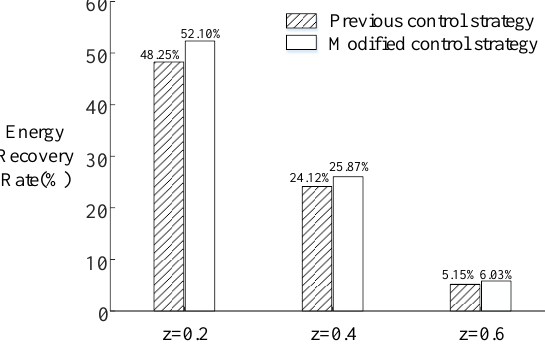
Figure 14. Simulation results comparison under different braking densities.